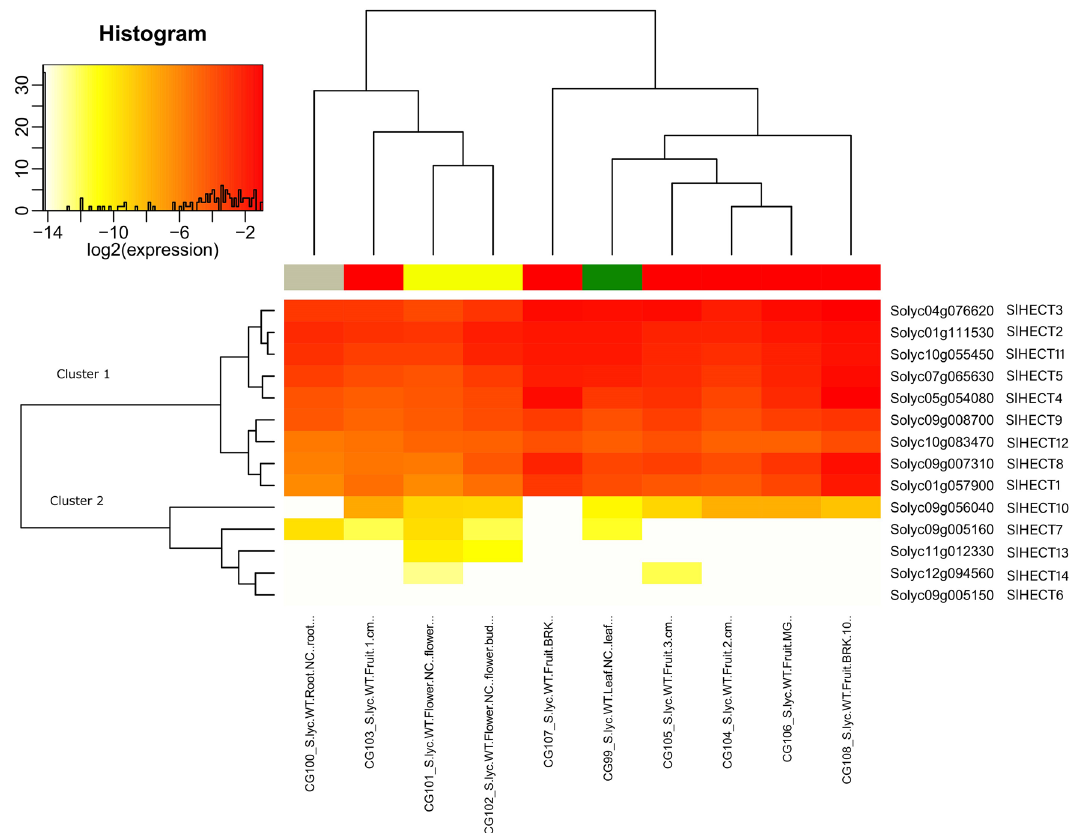
Figure 7. Gene expression levels of fourteen tomato HECT E3 ubiquitin ligase gene family members in vegetative and reproductive tissues (root, fruit, flower, and leaf tissues) represented by heat map (Supplementary Table